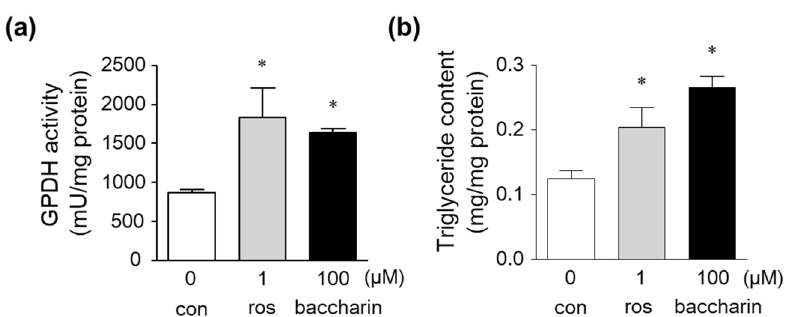
Figure 3. Effect of baccharin on GPDH activity and triglyceride levels in 3T3-L1 cells. Then, 3T3-L1 preadipocytes were cultured in the presence of insulin (1 µg/mL) with rosiglitazone (1 µM) or baccharin (100 µM). ( a ) GPDH activity and ( b ) triglyceride levels in the cultured cells were measured. Values are expressed as means ± SEM ( n = 3). * p < 0.05 compared with the control in the presence of insulin. ros, rosiglitazone; con, control.